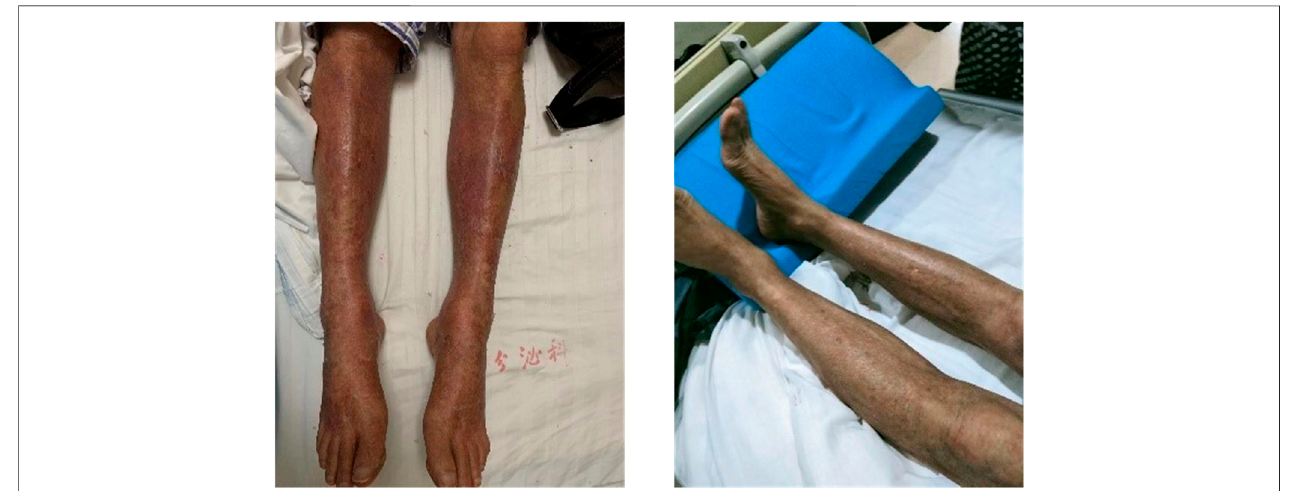
FIGURE 1 | Clinical features of the patient. (A) Rashes on the leg on admission; (B) Rashes on the leg post-recovery.